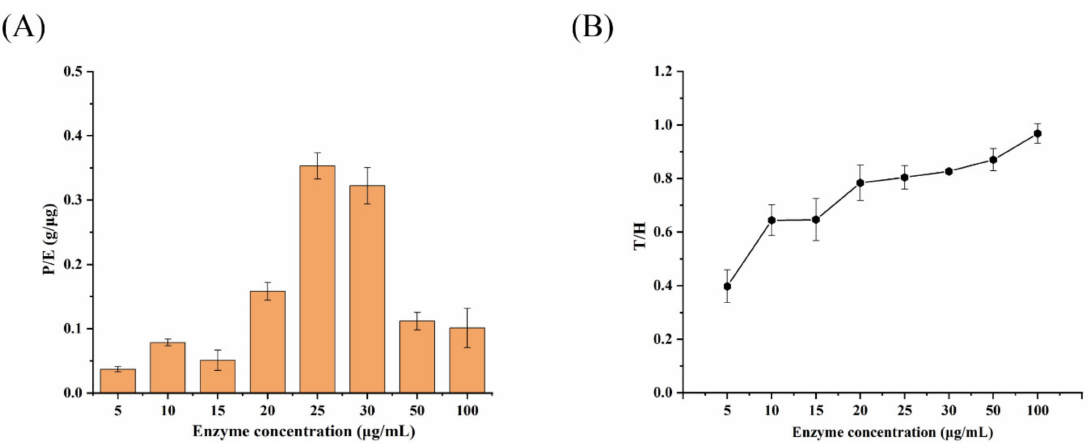
Figure 7. Effect of enzyme concentration on the P/E and T/H of the recombinant LS; P/E is the ratio of levan production and enzyme concentration. ( A ) Effect of enzyme concentration on P/E of Psor-LS. ( B ) Effect of enzyme concentration on T/H of Psor-LS. All of the values are the mean of triplicate experiments.